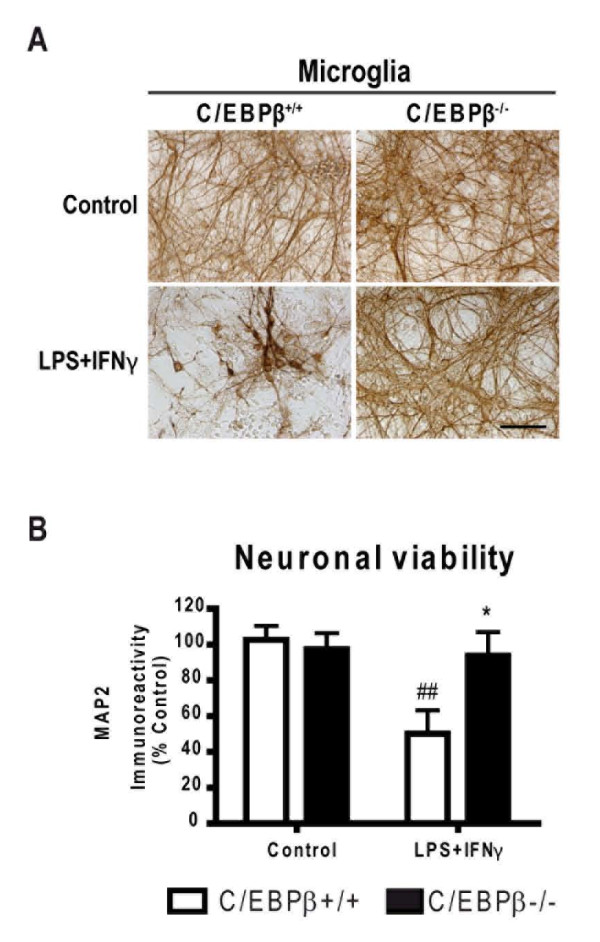
Lack of C/EBPβ in activated microglia completely abolishes the neurotoxic effects of activated microglia in neuronal-microglial co-cultures. A. MAP2 immunostaining of wild-type neurons co-cultured with C/EBPβ+/+ or C/EBPβ-/- microglia was performed 48 h after LPS+IFNγ treatment. MAP2 staining shows a clear decrease of network fibres caused by activated C/EBPβ+/+ microglia, but not by C/EBPβ-/- microglia or by vehicle-treated microglia. Images are representative of 5 independent experiments. (Bar = 100 μm). B. Evaluation of neuronal viability by MAP2/ABTS/ELISA assay 48 h after treatment with LPS+IFNγ or vehicle (control). Results are presented as % of MAP2 immunostaining in control cultures. Treatment with LPS+IFNγ reduces MAP2 immunostaining in neurons cocultured with C/EBPβ+/+ microglia, but not with C/EBPβ-/- microglia. Two-way ANOVA, followed by Bonferroni's test was applied. ##p < 0.01 compared with C/EBPβ+/+ control; *p < 0.05 compared to C/EBPβ+/+ LPS+IFNγ. (n = 5).